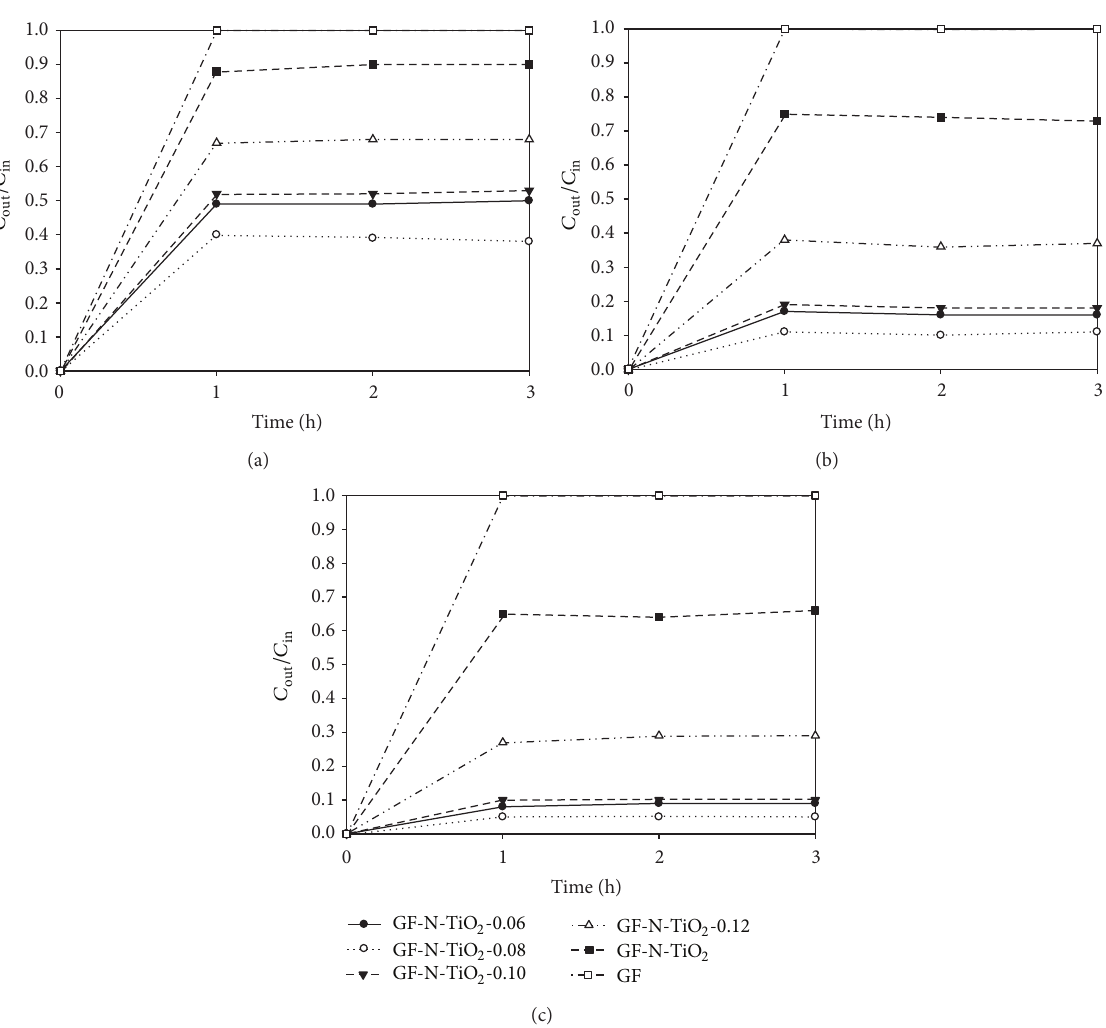
/𝐶 Figure 6: Time-series ratios ( 𝐶 ) of outlet-to-inlet concentrations of (a) toluene, (b) ethyl benzene, and (c) o-xylene as obtained using out in GF-N-TiO 2 photocatalysts with different N-to-Ti ratios (GF-N-TiO 2 -0.06, GF-N-TiO 2 -0.08, GF-N-TiO 2 -0.10, and GF-N-TiO 2 -0.12), GF- TiO 2 , and